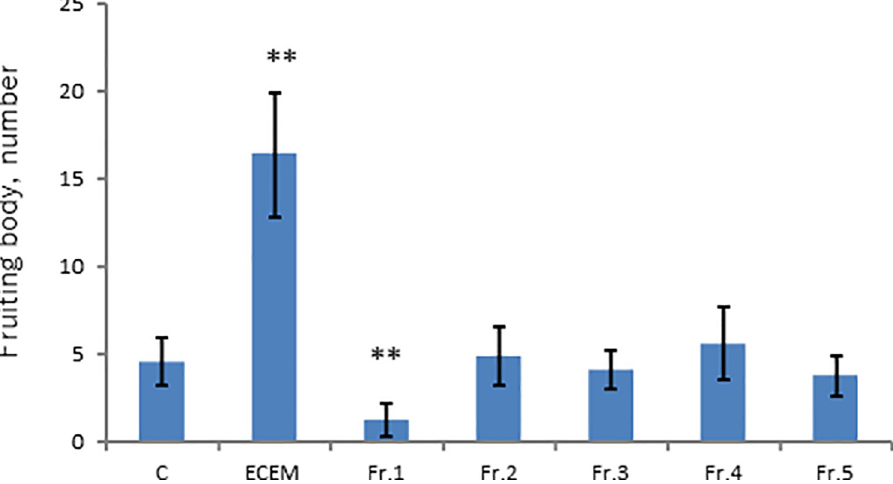
Fig 2. Chromatographic separation of aqueous phase in Fig 1. Aqueous phase was separated into 5 fractions and insoluble residue (S2 Fig). C (Control without ECEM); ECEM (10% ECEM). �� : Significant difference in comparison to the Control by Steel test (p <